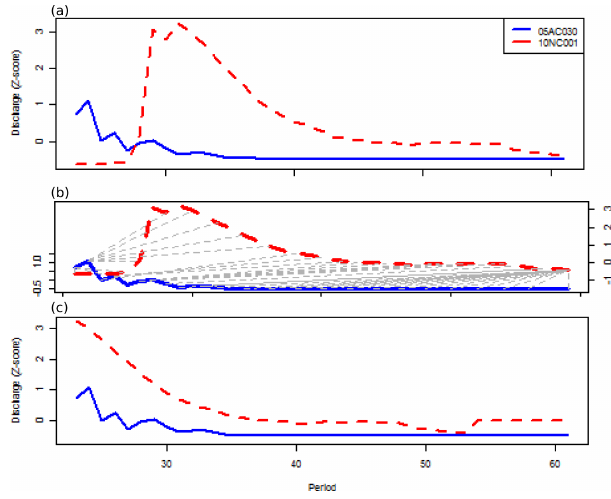
Figure 5. Example of alignment of two time series using dynamic time warping (DTW) from stations 05AC030 Snake Creek near Vul- can, AB, and 10NC001 Anderson River below Carnwath River,